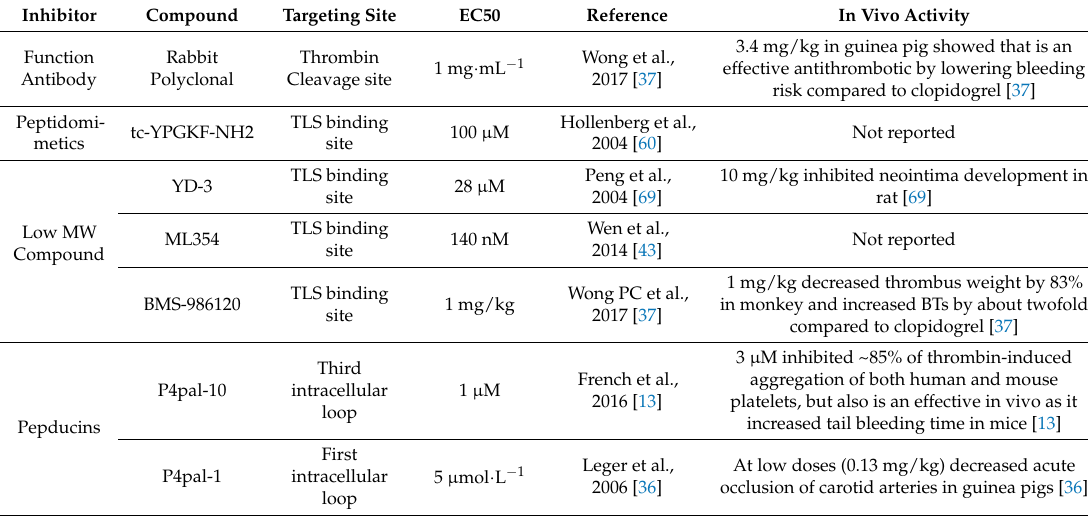
Table 1. The PAR4 inhibitors, their targeting sites and some of their in vivo